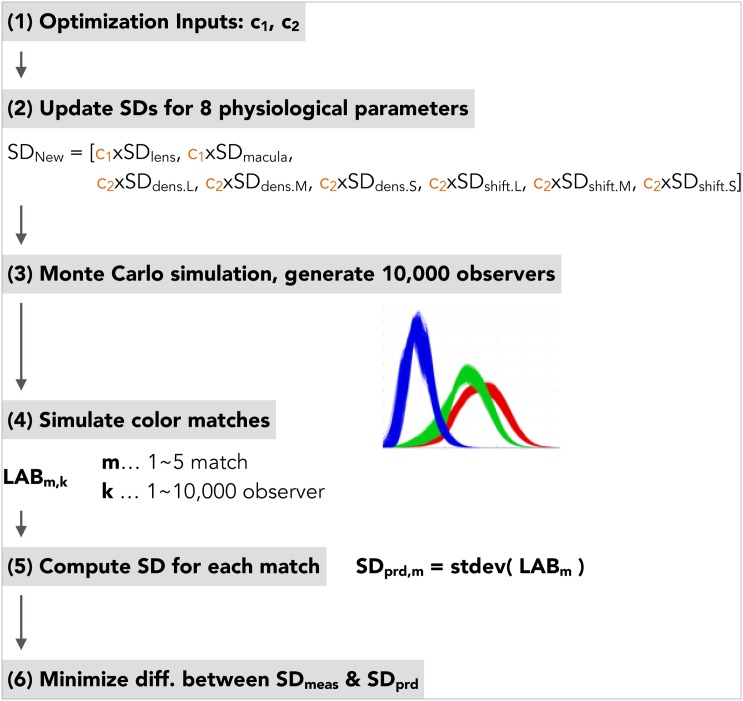
Workflow to optimize two scalars of eight physiological parameters.